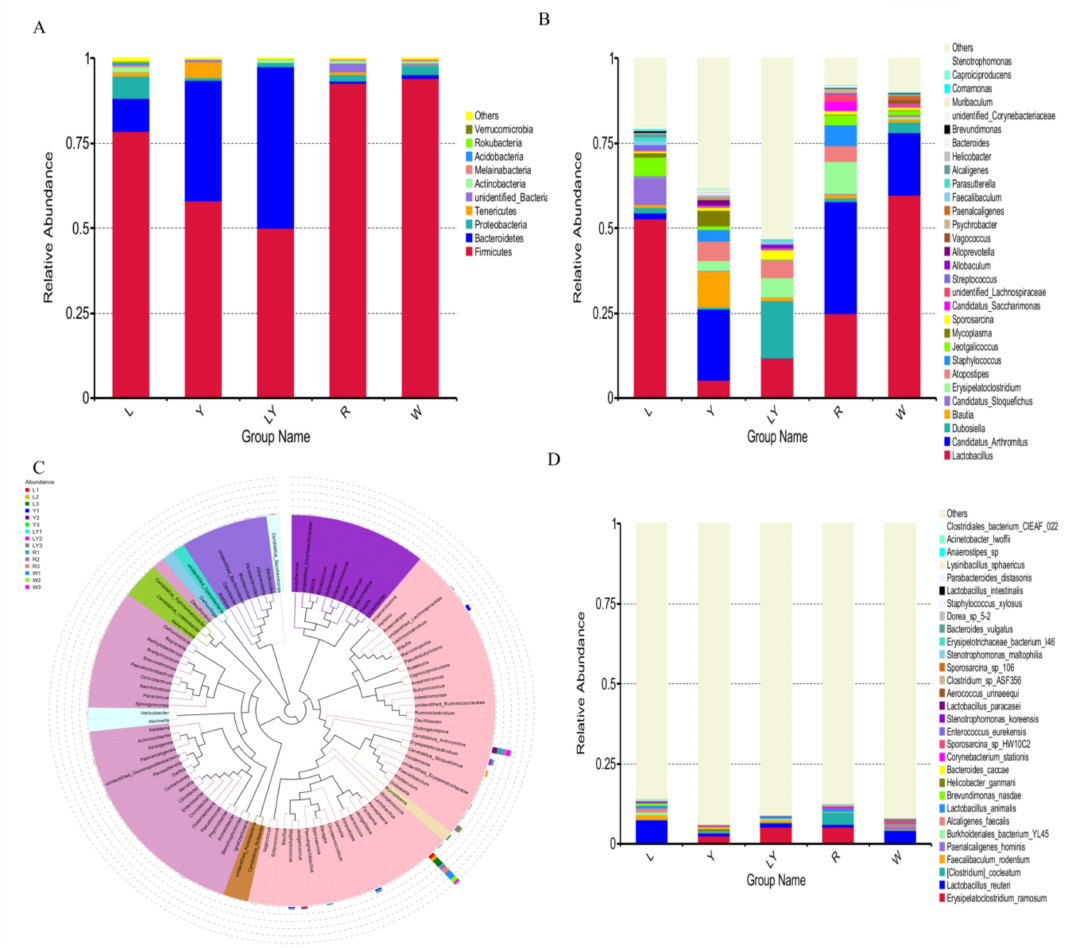
Figure 5. Microbial distribution of mice’s intestinal flora in different experimental groups (L-group, Y-group, LY-group, R-group and W-group): ( A ) phylum level, ( B ) genus level, ( C ) genus level evolutionary tree, ( D ) species